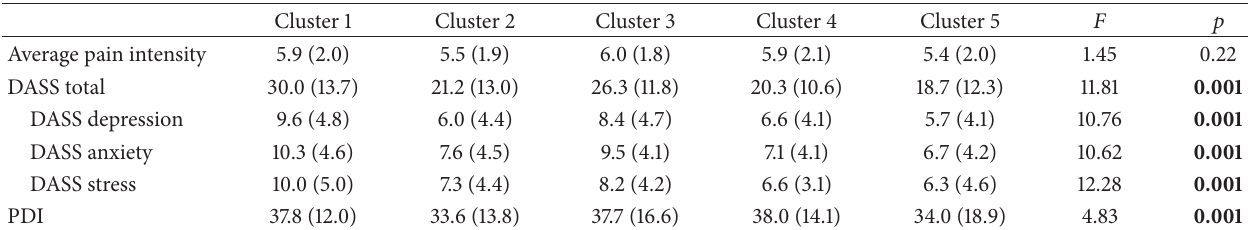
Table 3: Mean values (standard deviation) in pain intensity, mood, and disability among the cluster subgroups at 1 year follow-up.